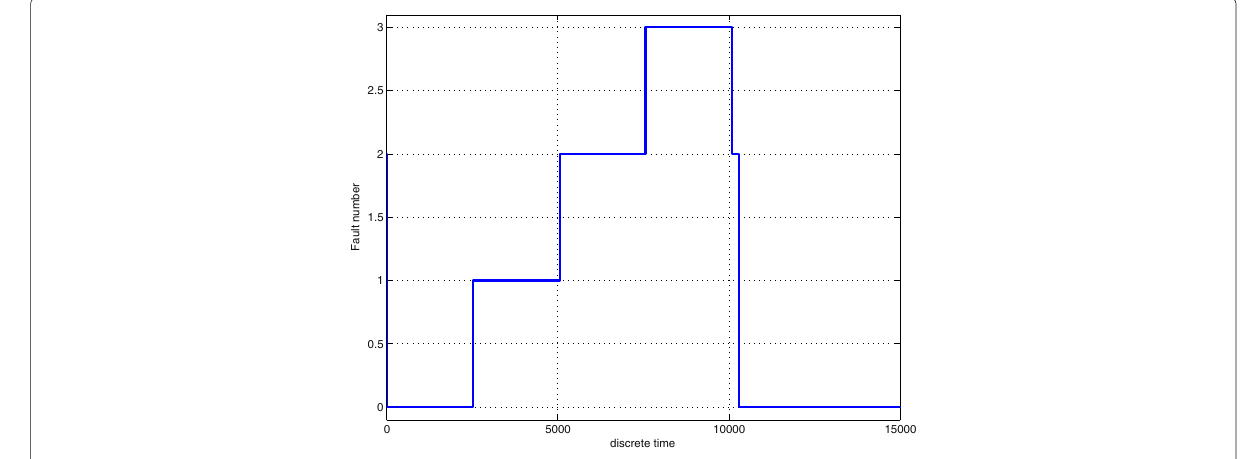
Fig. 6 Estimated fault number in the example 3, using Algorithm 2 as a function of time